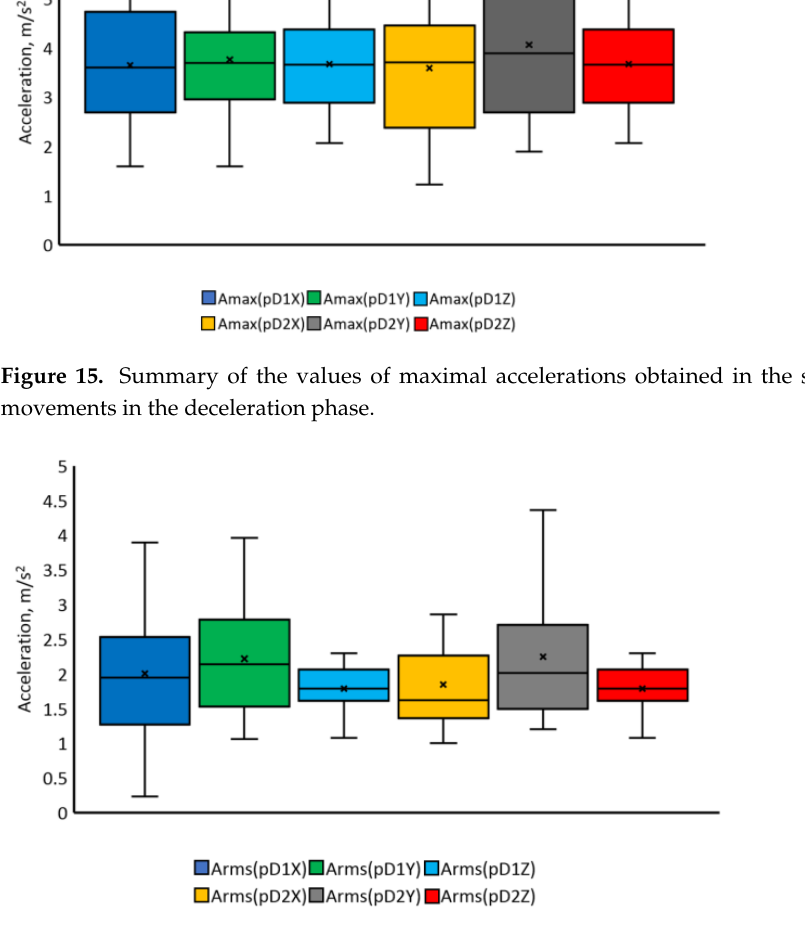
Figure 16. Summary of rms acceleration values obtained in the study of reaching movements in the deceleration phase.